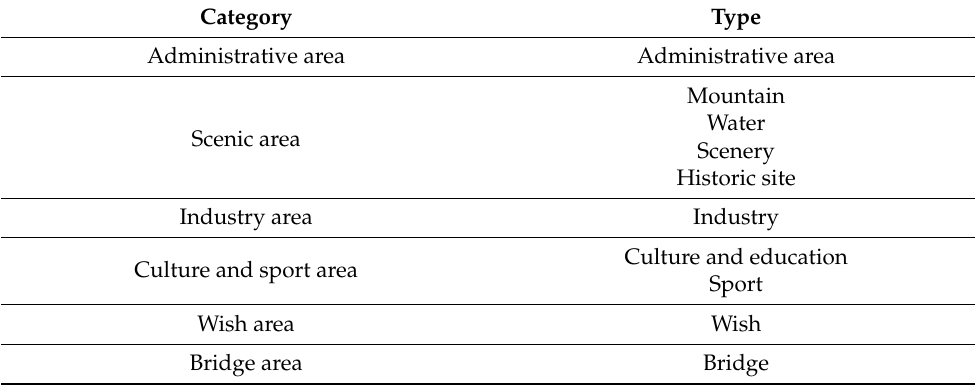
Table 4. The categories of aggregation areas and their corresponding street name